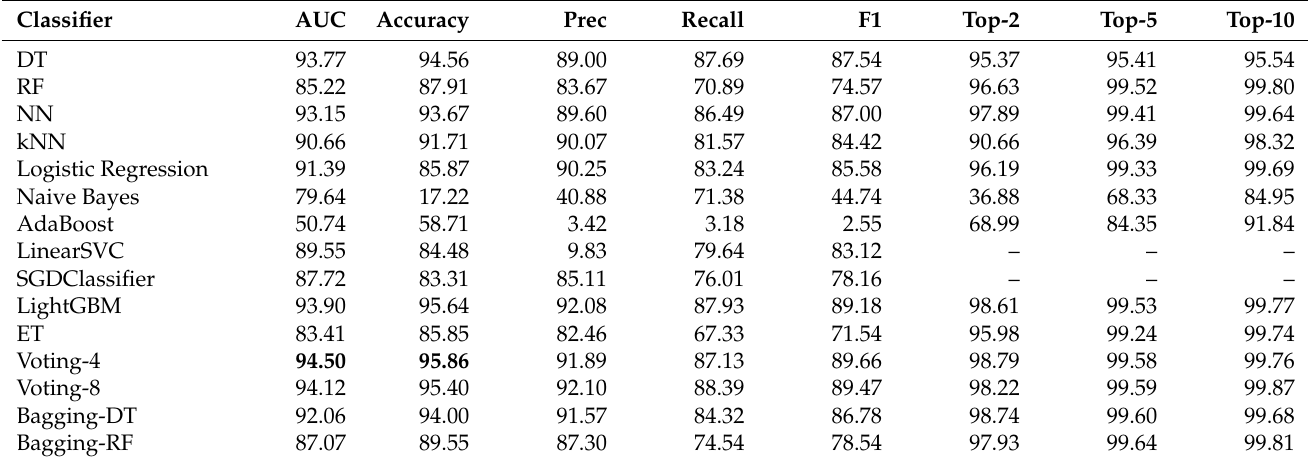
Table 4. Stratified 10-fold cross-validation results. Bold highlights best results.